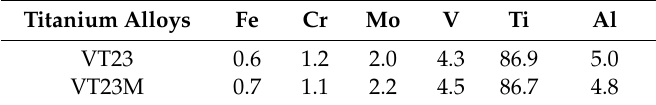
Table 3. Chemical composition of titanium alloys VT23 and